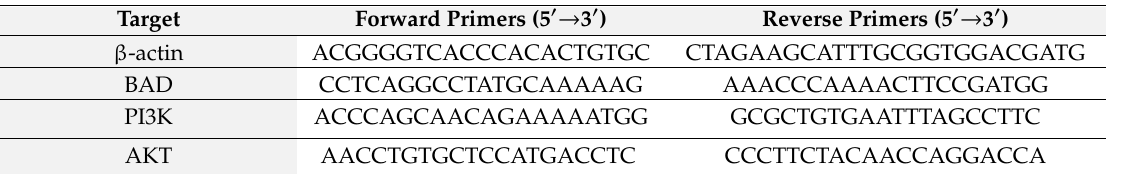
Table 4. Sequences of primers that were used to detect the expression of β -actin, BAD, PI3K, and